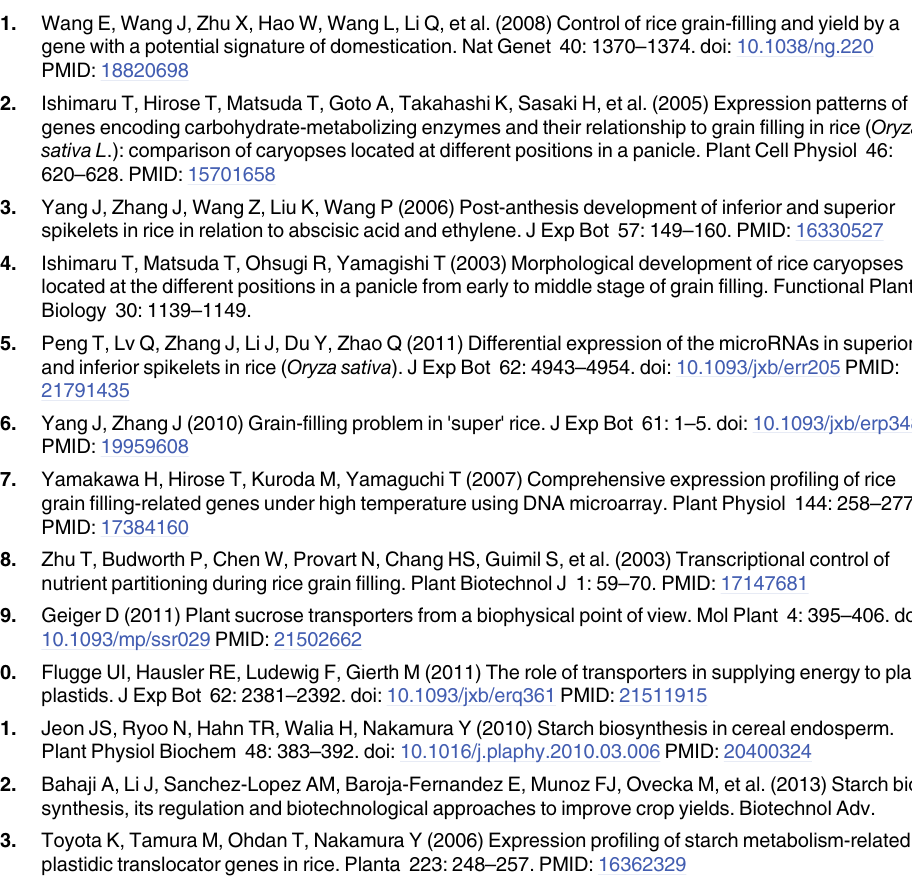
S3 Table. KEGG pathway classification of expressed genes in superior and inferior grains.